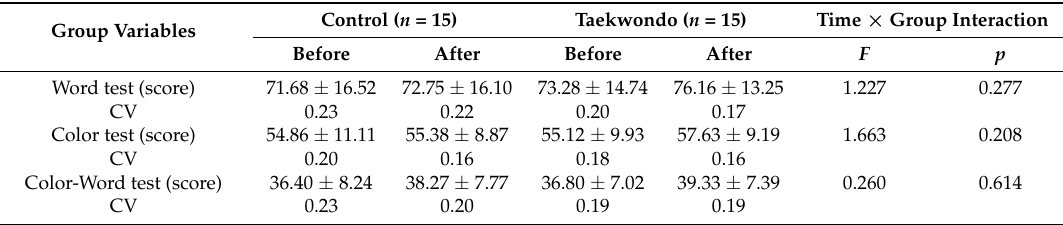
Table 6. Changes in cognitive